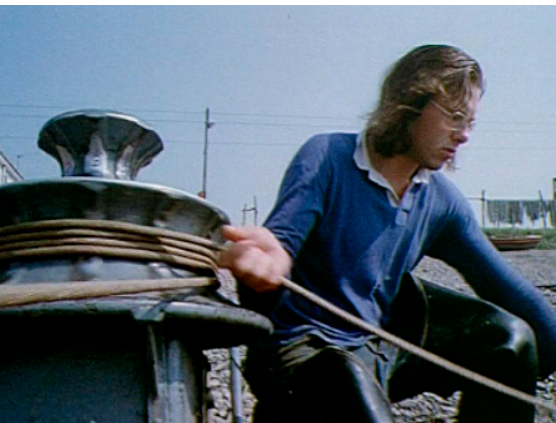
Figure 1. Bob spent his summers and also some Easter vacations working as a net fisherman for the Tay Salmon Fisheries Company between 1968 and 1974. He is seen here in his waders sitting by the winch, which pulled in the net at the fishing station Venture on the north bank of the Tay, in a still picture taken from a promotional film to promote the region. He was a gaffer or foreman of his crew from 1970 onwards.